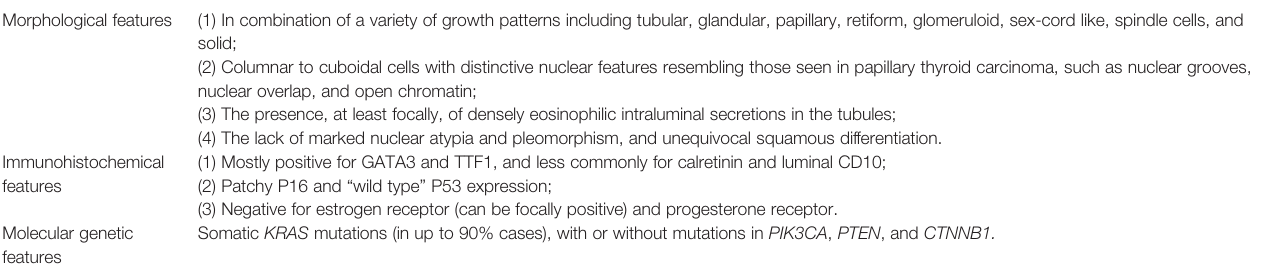
TABLE 5 | The most useful histopathologic and molecular genetic features for the diagnosis of uterine corpus mesonephric-like adenocarcinomas. Morphological